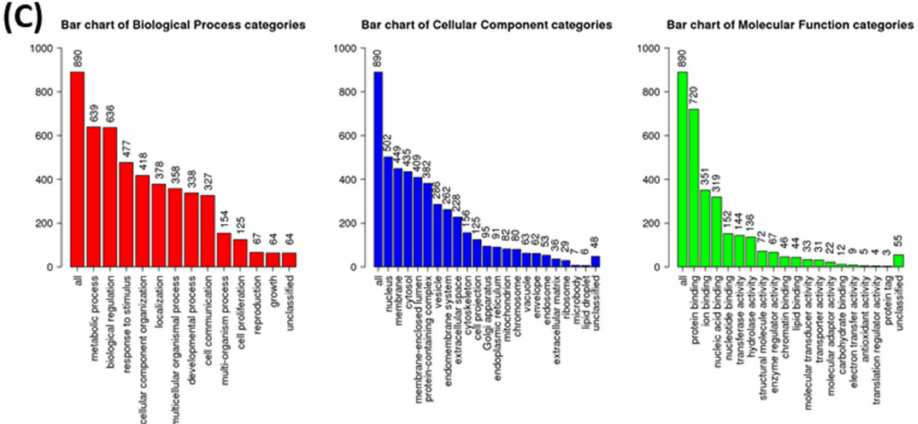
Figure 5. GOslim summaries for DIRAGs identified as higher reactive in ( A ) seropositive RA versus seronegative RA, ( B ) seronegative RA vs. seropositive RA and ( C ) PIA animals 7 and 24 days after disease induction corrected for signatures of control